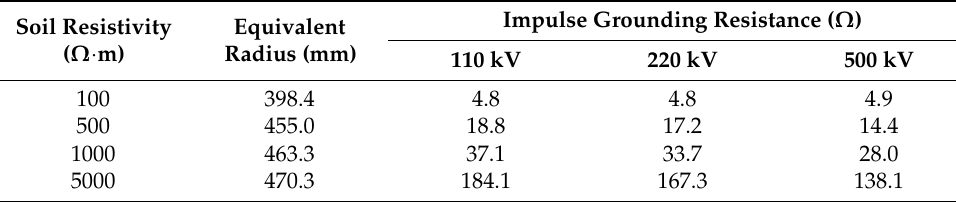
Table 10. Impulse grounding resistance of tower foundation with four